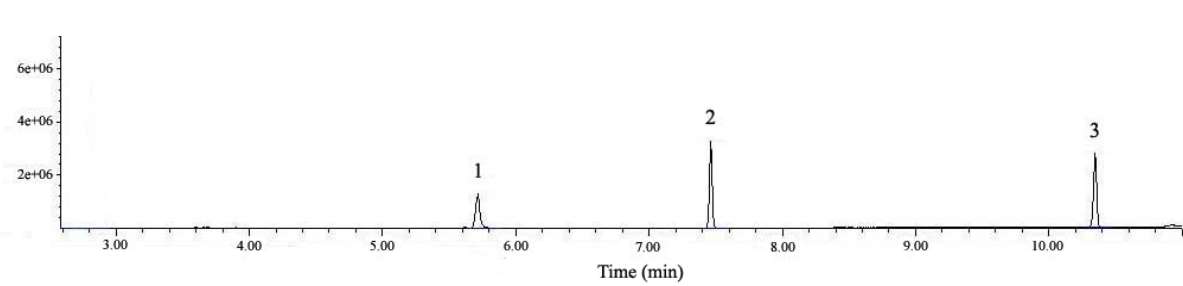
Figure 2. Total ion chromatogram (TIC) of a standard mixture of Labrasol ® and Transcutol ® by GC-MS. Peak 1: Transcutol ® , Peak 2: caprylic acid in Labrasol ® , and Peak 3: capric acid in Labrasol ®